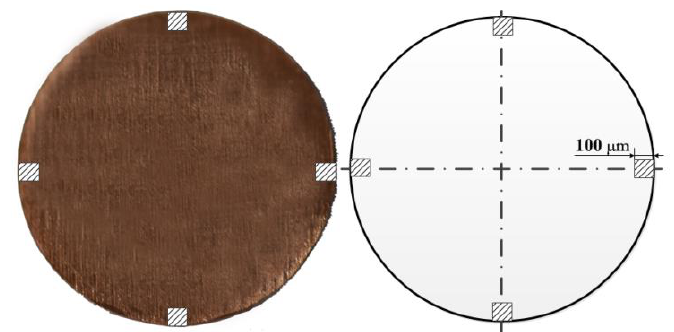
Figure 18. Surface roughness measurement area and its dimensions.